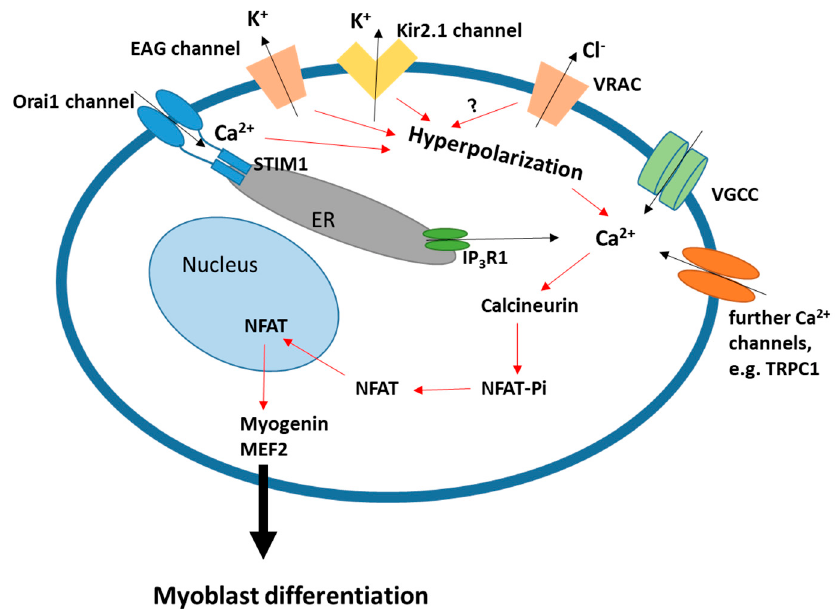
Figure 2. Membrane hyperpolarization and calcium signaling in myoblast differentiation. The sequential activity of EAG and Kir2.1 K + channels leads to membrane hyperpolarization, which in turn is required for Ca 2+ signaling. Ca 2+ release from the ER, which leads to activation of SOCE, can contribute to the Ca 2+ signal. Activity of the Cl − channel VRAC contributes to hyperpolarization by an unknown mechanism. See the main text for details.